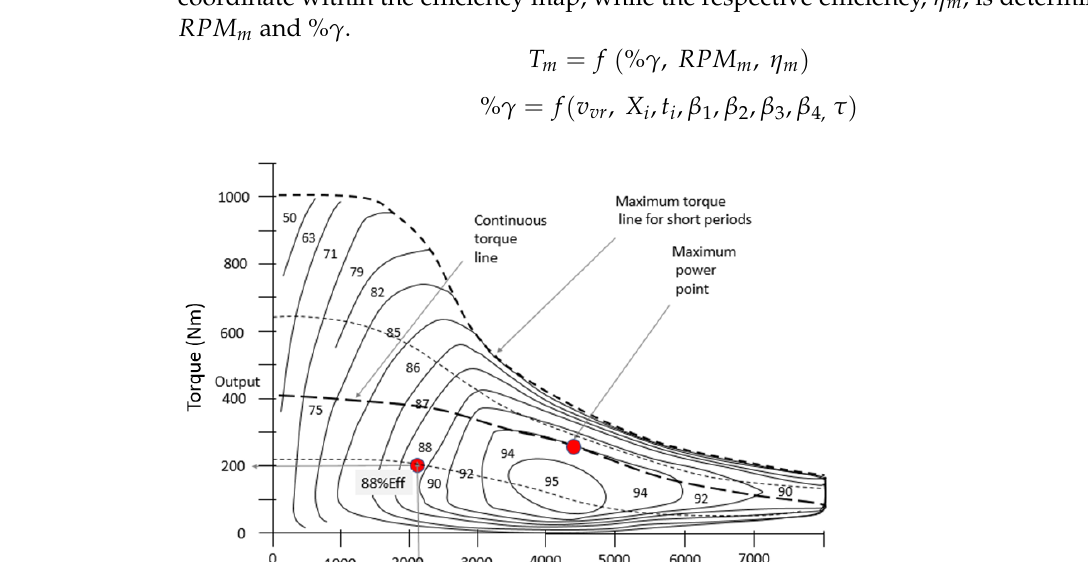
indicates whether the vehicle is approaching a regu- indicates the presence and distance of vehicles in front. 𝛽𝛽 1 indicates varying road conditions: humidity, 𝛽𝛽 2 𝛽𝛽 4